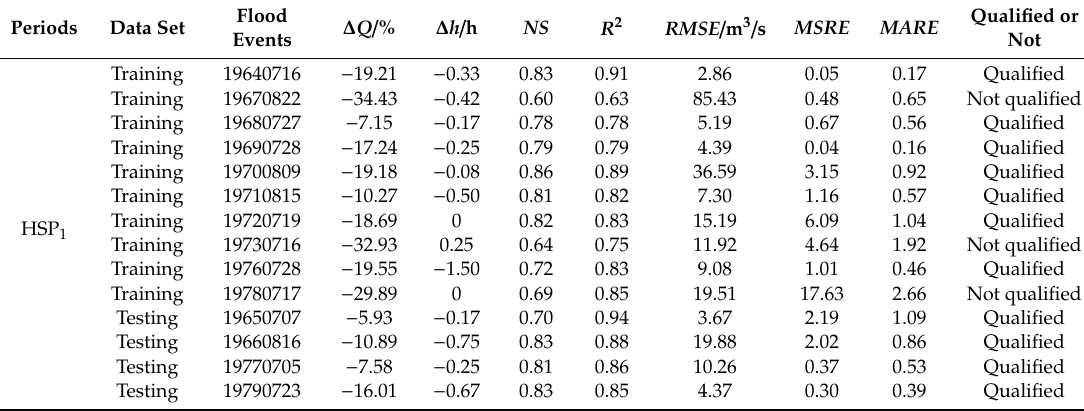
Table 3. Evaluation of flood simulation results by ELM (extreme learning machine)